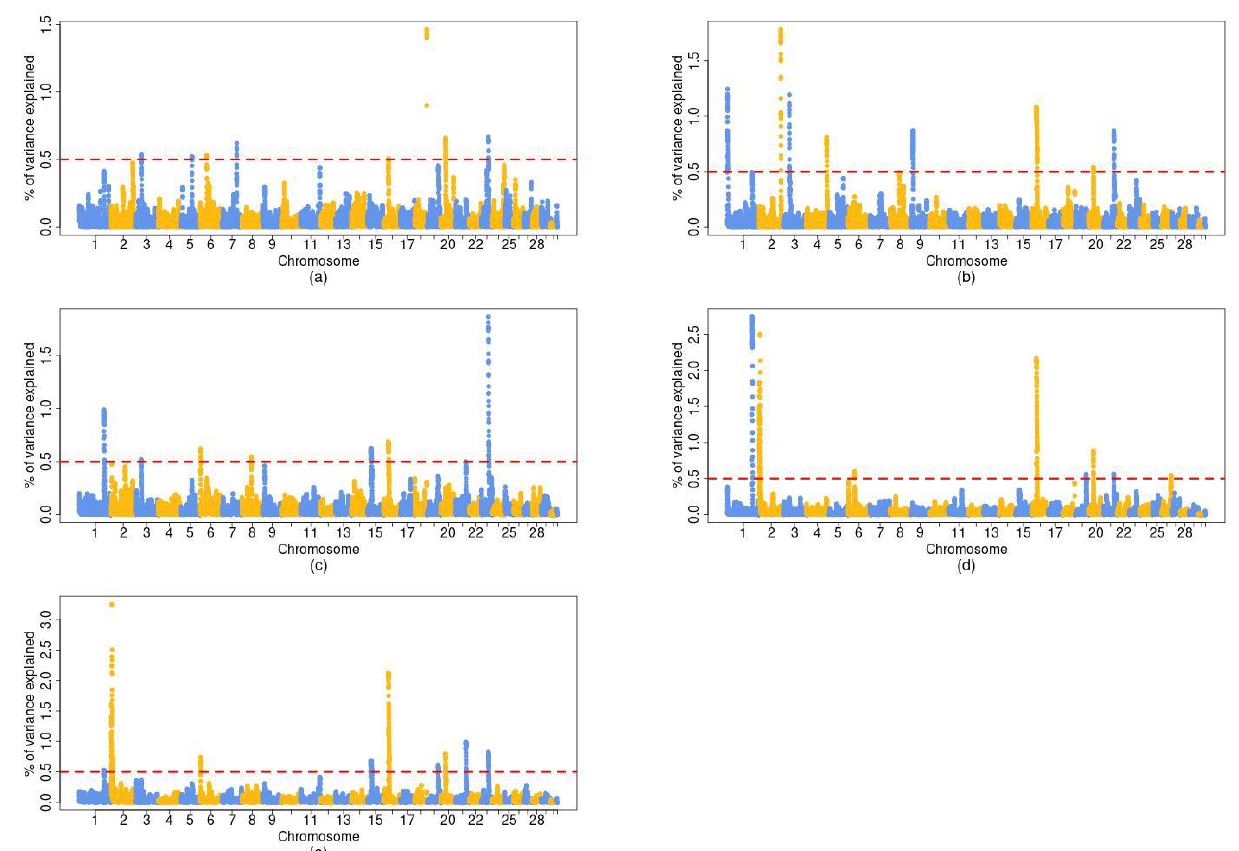
Figure 1. Manhattan plot of genomic sweep from the standardized additive genetic variance (y axis) explained at each of the SNPs by a distance of 1 Mb of pair bases, for traits: ( a ) BW: Birth Weight, ( b ) WW: Weaning Weight, ( c ) CCW: Cold Carcass Weight, ( d ) FAT: Fatness, and ( e ) CON: Conformation with the identified genomic regions that explained the percentage of additive genetic variance above 0.5% (dashed red line). Table 3. Regions of the genome that explained a percentage of variance above 0.5% and the pair bases distance, the traits 1 in which these regions appear, and the candidate genes with a pleiotropic effect.